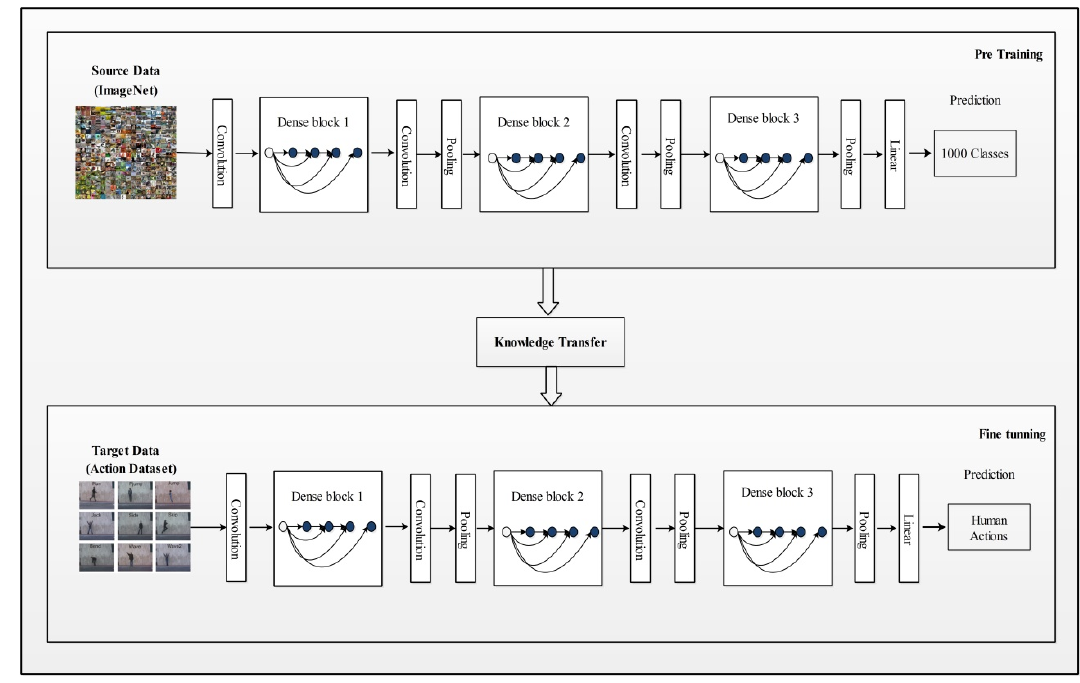
Figure 5. Target model (modified DenseNet201) for feature extraction.